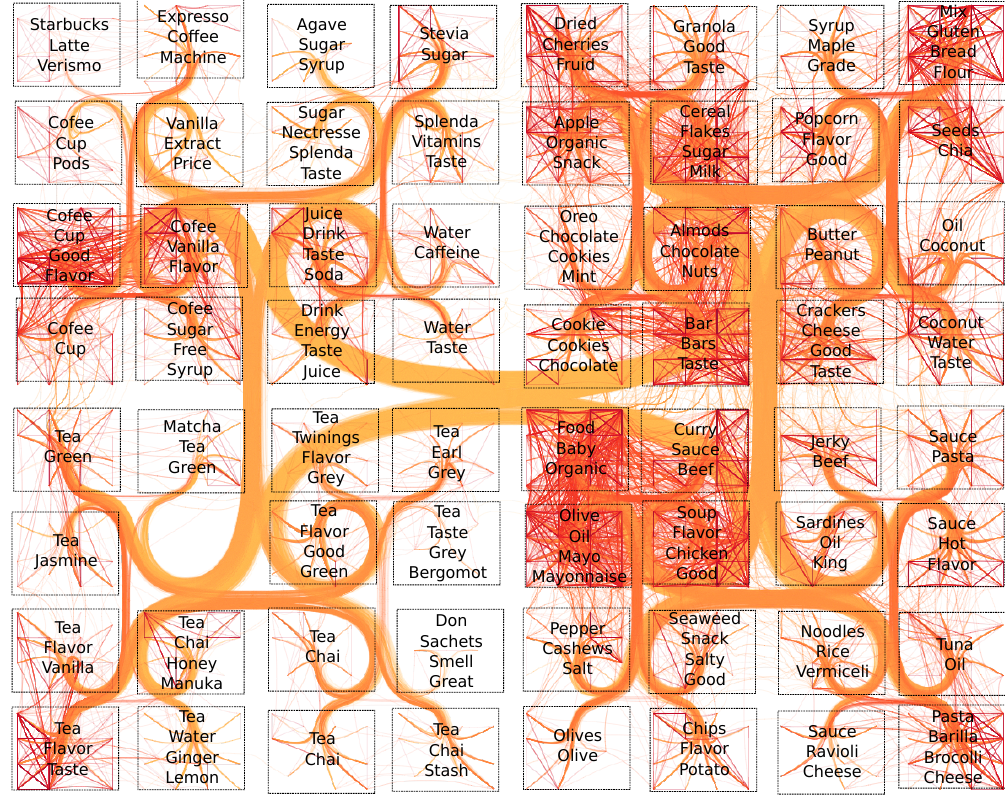
Figure 17. SDEB layout of the dataset amazon dataset. The visualization is limited at the 9th graph level. Vertices were divided into 63 groups and each group is highlighted with its most common topics, extracted from the set of reviews written by